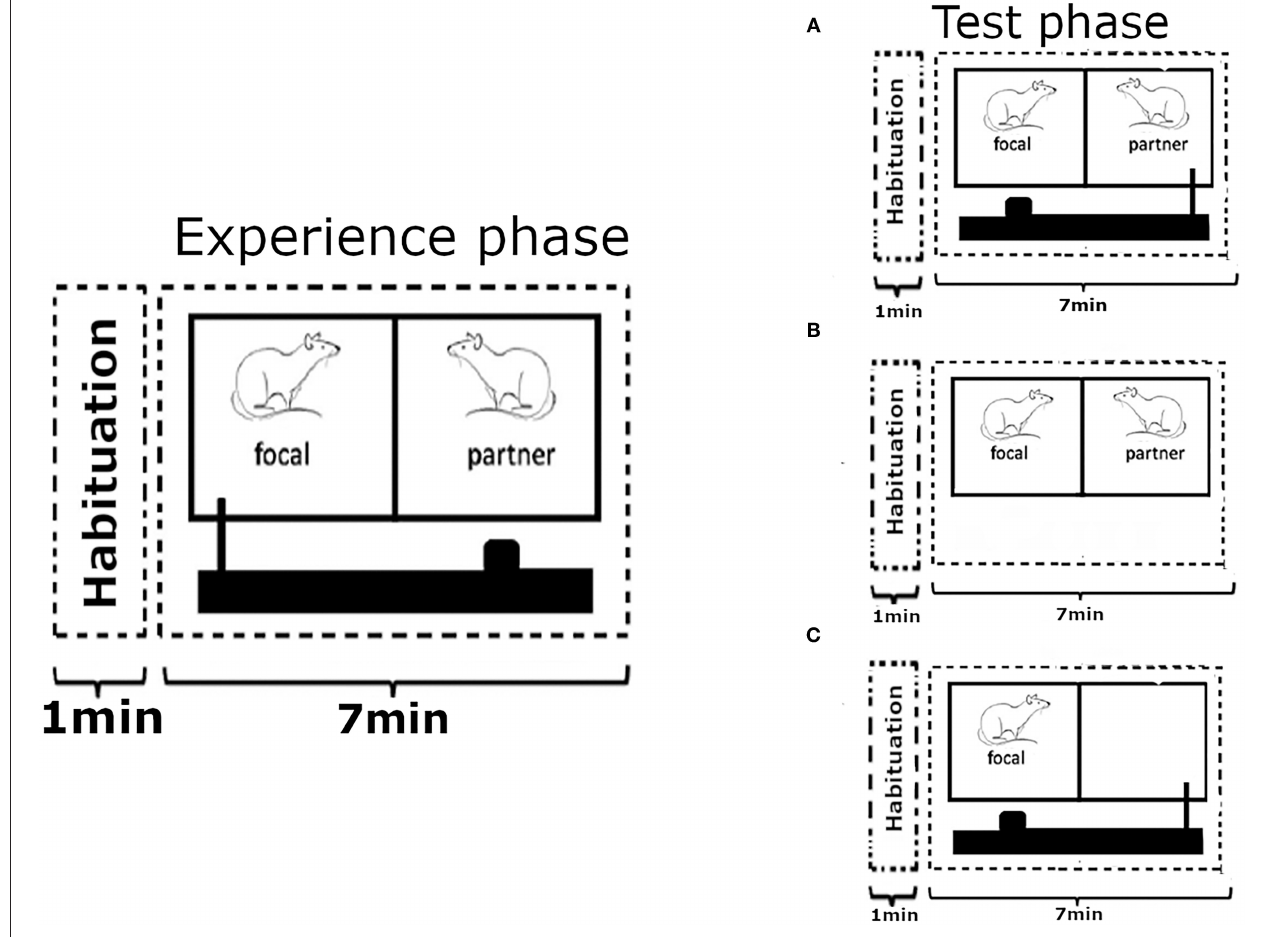
FIGURE 1 | Outline of the experimental design. Each test phase was preceded by an experience phase where the focal animal could provide food to its partner an undetermined number of times, over 7 mins, by pulling a baited tray with a wooden stick towards the cage. On the following day, after 18h of food deprivation, the focal animal was returned into the experimental cage where the roles were reversed and (A) the partner rat could now provide food to the focal subject. In the first control condition (B) the partner from the previous day was present in the neighbouring cage compartment, but no moveable tray with food was present. In the second control condition (C) the focal rat was on the receiving side of the food tray like in condition (A) , but no partner was present to move it. Each focal animal went through all three experimental treatments in a random order, each time preceded by the experience phase with a new partner on the previous day. Figure modelled on comparable depiction in Schweinfurth and Taborsky